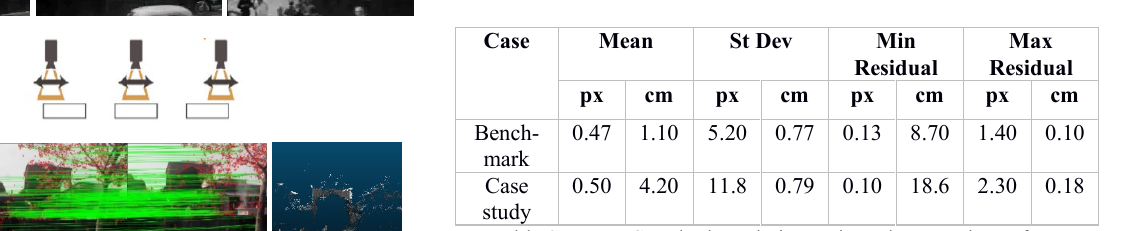
Table 3. Mean, Standard Deviation, Min and Max values of residuals for Les Halles compared with the trucking benchmark.